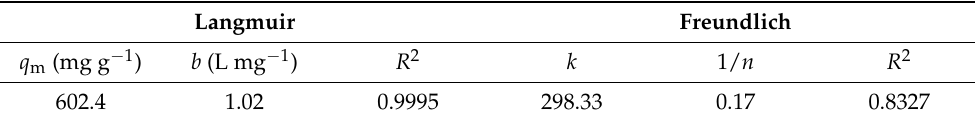
Table 2. Langmuir and Freundlich isotherms parameters.